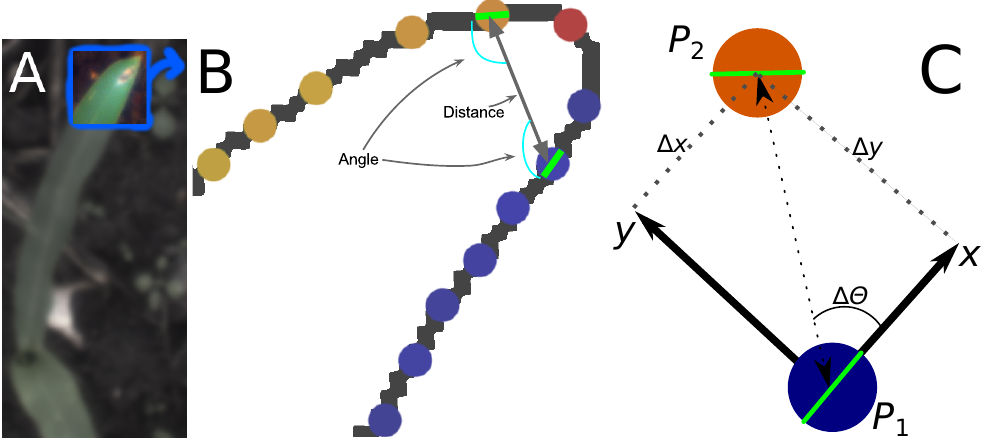
Figure 2. ( A ) Image of the leaf tip used in the example; ( B ) Edge segments along the leaf edge; ( C ) Two edge segments outlined with the relative coordinates from P 1 to P 2